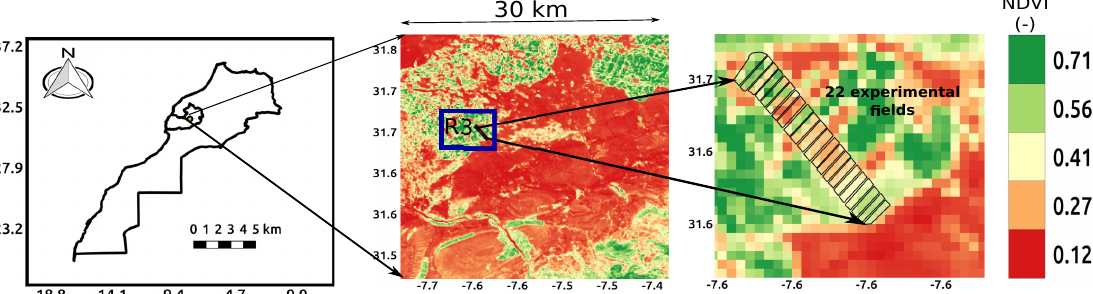
Figure 1. Location of Marrakesh, the Haouz plain in central Morocco and the 22 experimental crop fields in the R3